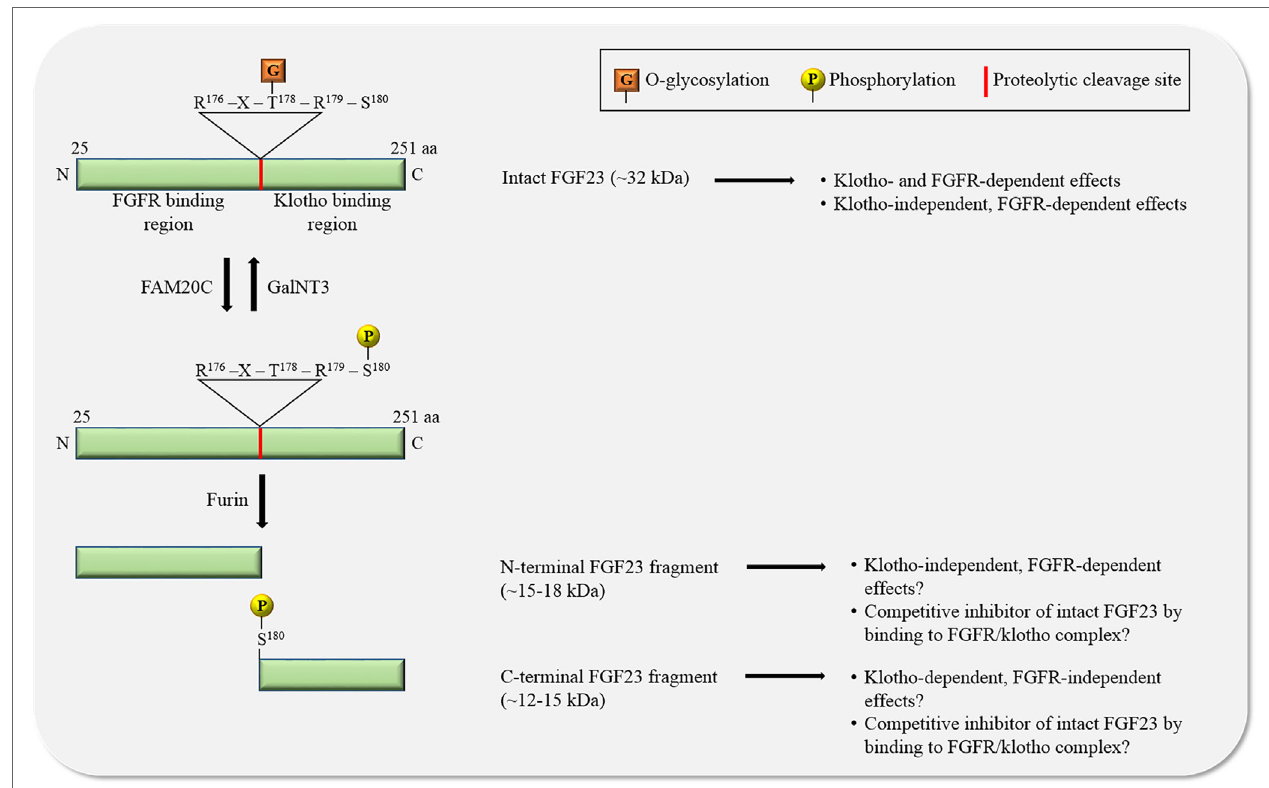
FiGURe 2 | The regulation of FGF23 by posttranslational modifications. O-glycosylation by N -acetylgalactosaminyltransferase 3 (GalNT3) at threonine residue 178 (T 178 ) protects FGF23 from proteolytic cleavage resulting in the generation of intact, biologically active FGF23. Phosphorylation of FGF23 on serine residue 180 (S 180 ) by family with sequence similarity-20 member C (FAM20C) prevents O-glycosylation and promotes proteolytic cleavage by furin proteases. The biological relevance of the two generated FGF23 fragments is unclear. Abbreviations: aa, amino acid; N, N-terminus; C,